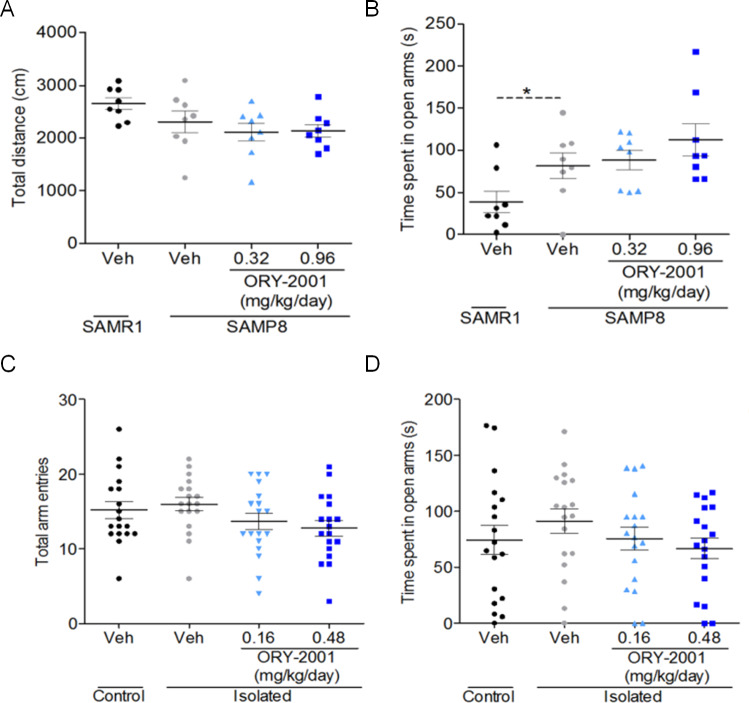
ORY-2001 does not have anxiolytic or sedative effects.Effect of ORY-2001 on SAMP8 mice: (A) Locomotor activity as assessed by total distance travelled in the open field test (N = 8/group), (B) anxiety as assessed by the time spent in the open arms in the elevated plus maze (t(14) = 2.183; p = 0.0465; N = 8/group), Effect of ORY-2001 on rats in the isolation rearing model: (C) Locomotor activity (N = 18/group) and (D) anxiety in the Elevated Plus Maze (N = 18/group); Means and SEM are represented. SAMR1 and SAMP8 vehicle or Non Isolated and Isolated groups were compared by Student’s t-test. Within SAMP8 mice or Isolated groups, different drug treatments were compared by t-test or one way-ANOVA with Dunnett and SNK post-hoc analysis. *p < 0.05, **p < 0.01, ***p < 0.001.